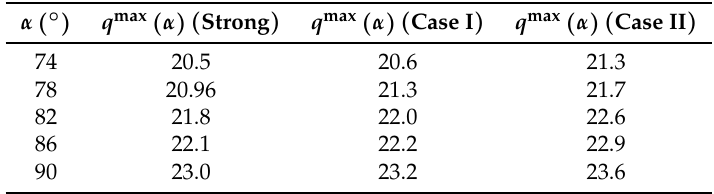
Figure 7. ( a ) Plot of the growth rate s ( q x d / π ) vs. dimensionless wavelength q x d / π obtained for a number of values of the anchoring strength W [11,18]: cases I (curve 1) and II (curve 2), as well as for the case of the strong anchoring (curve 3), respectively. ( b ) Same as Figure 6, but for a number of values of the angle α : 1.22 ( ∼ 70 ◦ )(curve (1)); 1.29 ( ∼ 74 ◦ )(curve (2)); 1.36 ( ∼ 78 ◦ )(curve (3)); 1.43 ( ∼ 82 ◦ )(curve (4)), and 1.50 ( ∼ 86 ◦ )(curve (5)), respectively. Table 1. The optimal values of the dimensionless wavelength q max x ( α ) as a function of both the angle α and the anchoring strength W